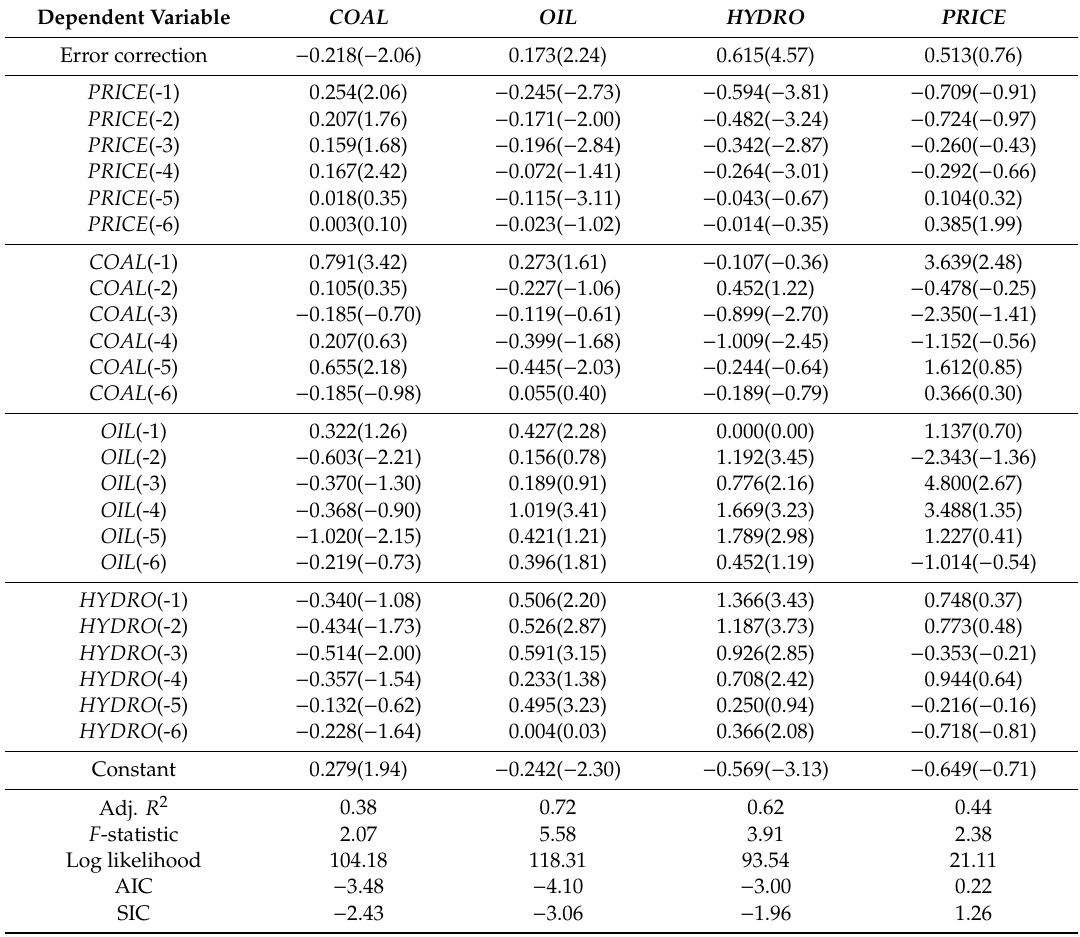
Table 8. Estimates of error-correction models